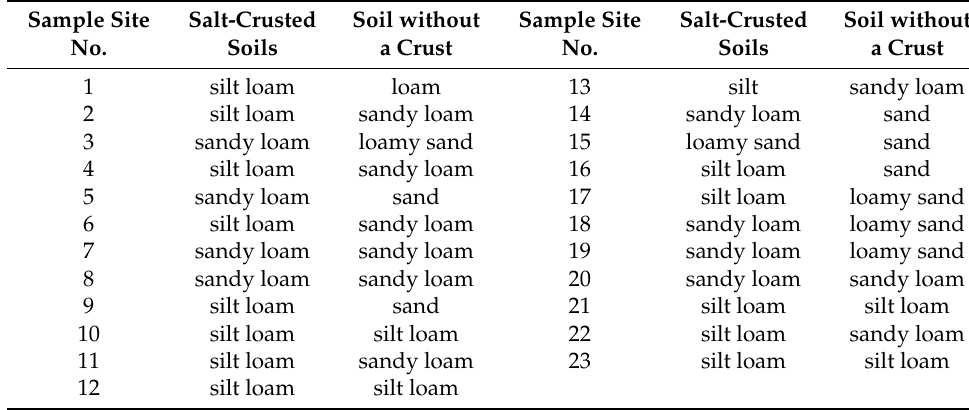
Table 2. Texture of soils with and without a salt crust at the sampling